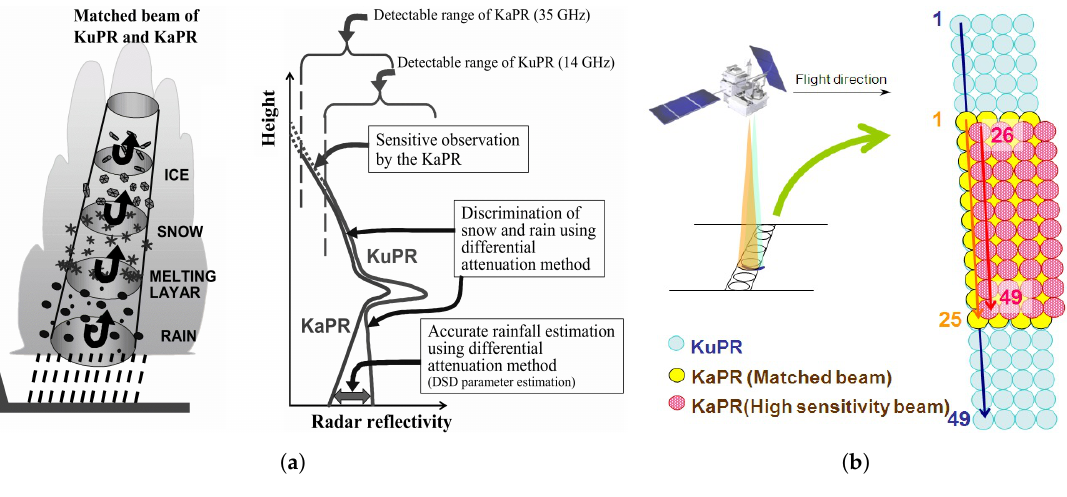
Figure 1. ( a ) Concept of DPR dual-frequnecy observation. Image source: Senbokuya et al. [5]; ( b ) GPM-DPR scan strategy. Image taken from GPM Level 2 algorithm theoretical basis document